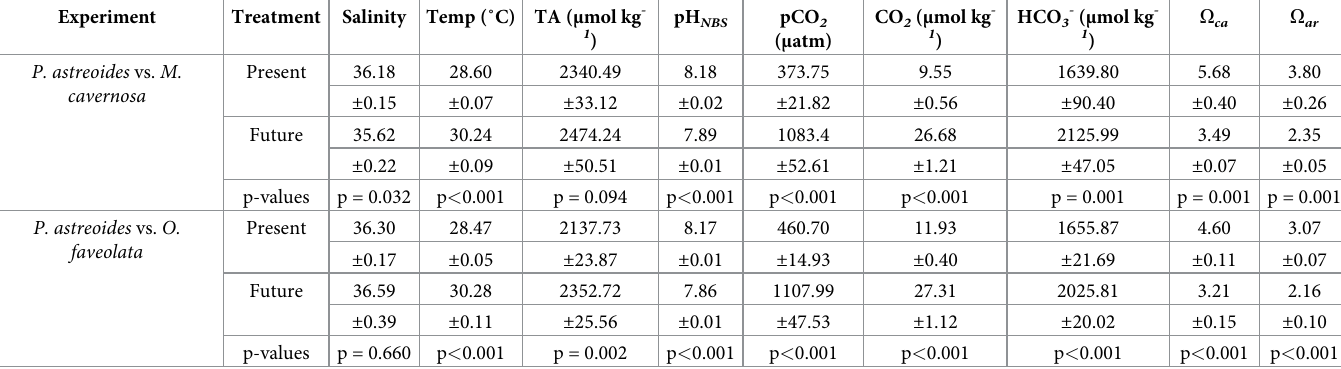
Table 1. Average ( ± SE) calculated carbonate chemistry parameters from the measured parameters of pH, total alkalinity (TA), temperature, and salinity (n = 6).